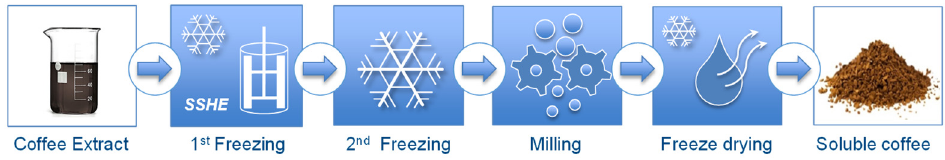
Figure 1. Process overview: from coffee extract to soluble coffee.